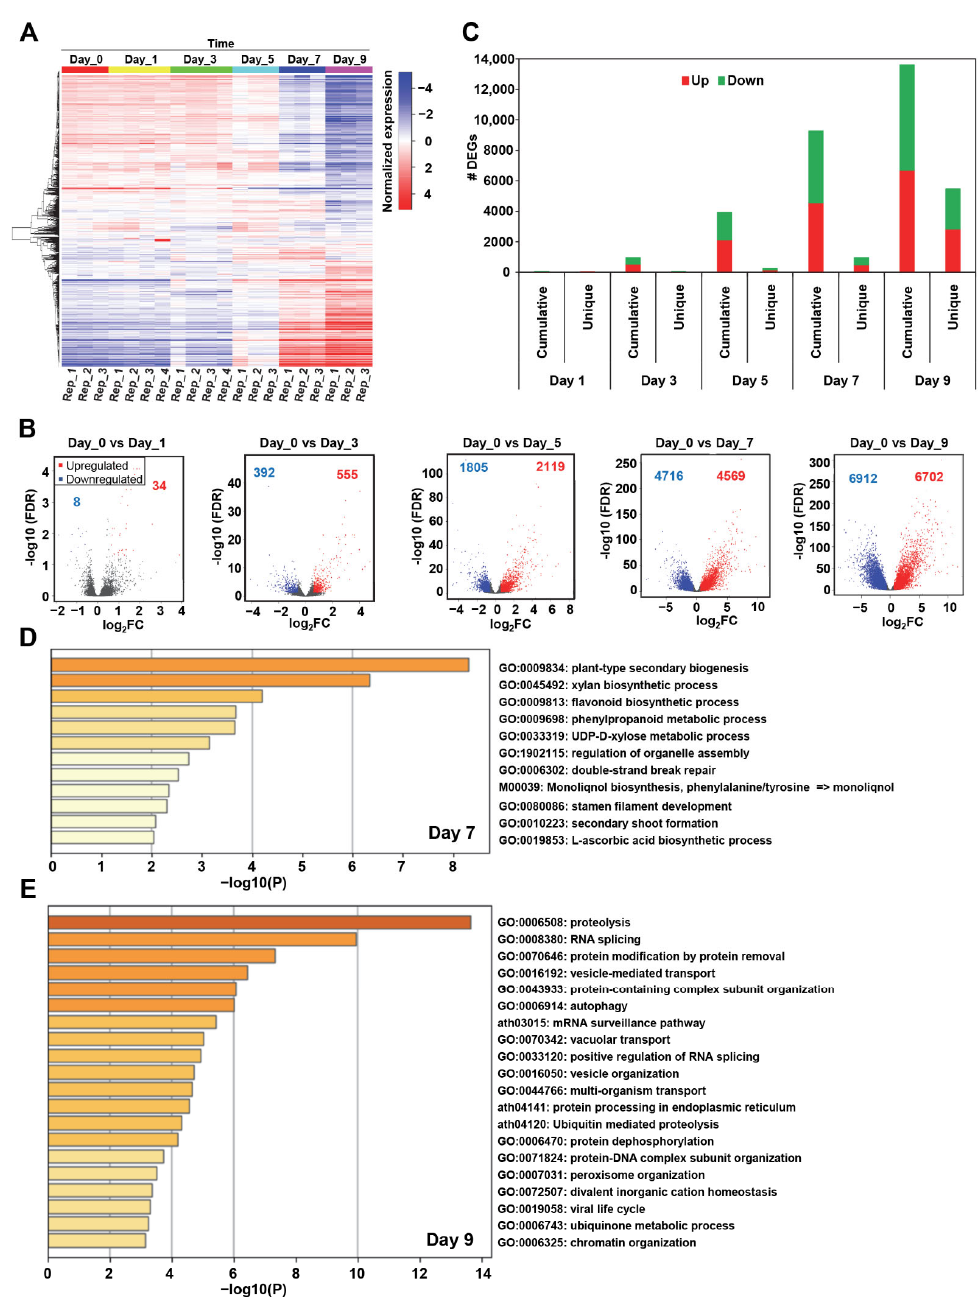
Figure 1. Arabidopsis transcriptome dataset (GSE76827) displays more change in the expression patterns at later sampling days of drought stress. ( A ) Heatmap of the gene expression profile of Arabidopsis under drought conditions on different sampling days (as indicated). The color bars display the normalized gene expression (Red ≥ 1, Blue ≤ − 1). ( B ) The total number of uniquely expressed genes on days 1, 3, 5, 7, and 9 are shown in the plots. ( C ) Differential gene expression is displayed during the drought treatment time frame. The total number of genes significantly deferentially expressed were 42, 947, 3924, 9285, and 13,614, respectively, on days 1, 3, 5, 7, and 9(false discovery rate (FDR) ≤ 0.05, log2 Fold Change (log2FC) ≥ |0.58|). Red dots correspond to up-regulated genes, while blue points indicate down-regulated genes. ( D , E ) The gene ontology (GO) enrichment analysis of Arabidopsis unique differentially expressed genes (DEGs) on day 7; ( D ), and day 9; ( E )) after drought stress is presented ( p -value ≤ 0.05). The color gradient of bars in the gene enrichment analysis represents low (yellow) to high (red) enrichment significance